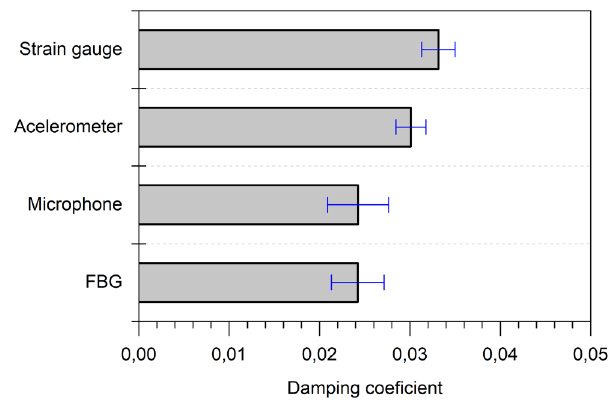
Figure 16. Sample damping